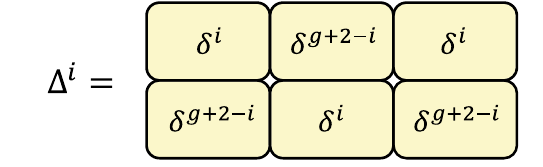
FIG. 10. Extended diagonal Δ i